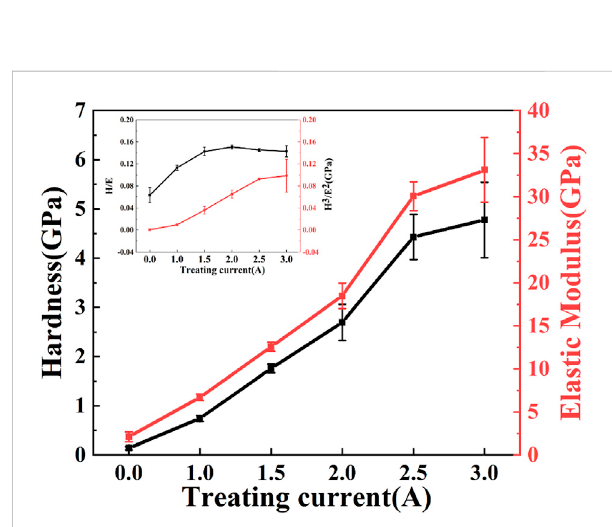
FIGURE 7 The microhardness and the elastic modulus of PI surface treated with different graphite target currents.